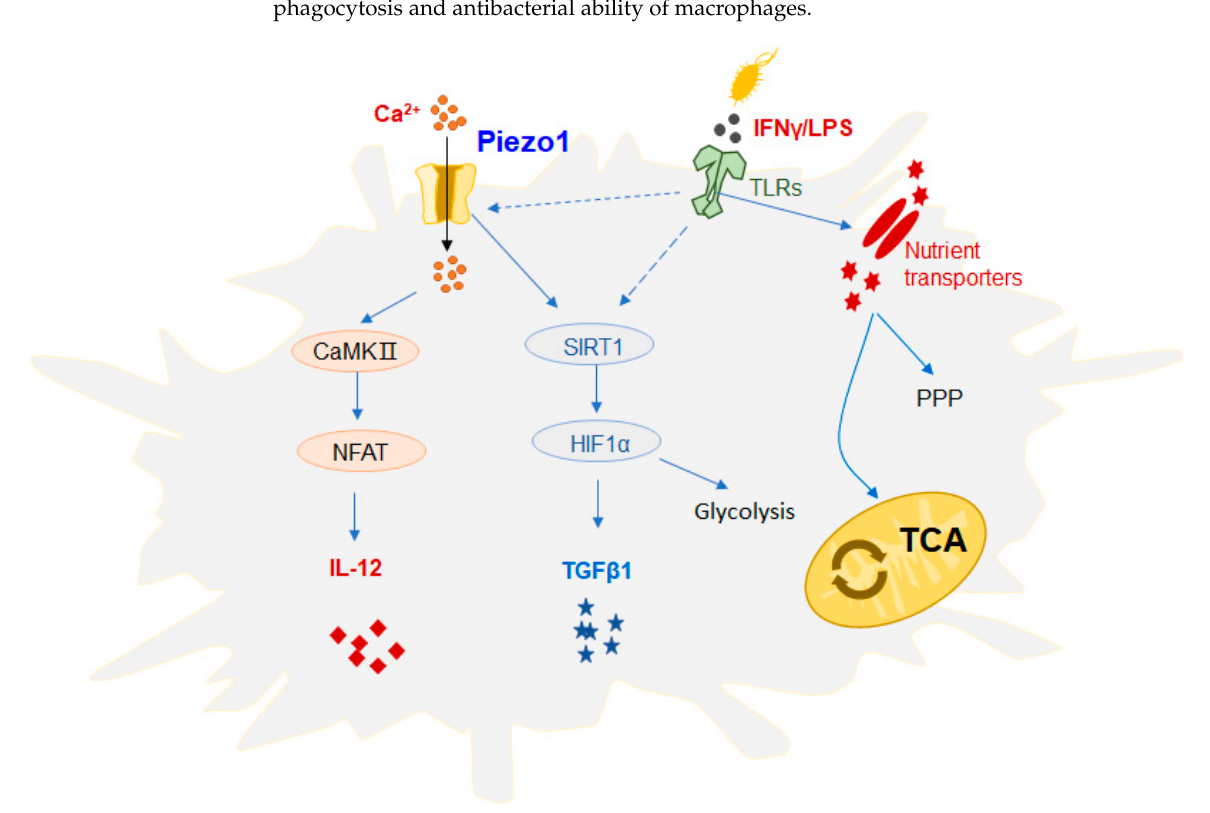
Figure 2. Piezo1 regulates the function of macrophages.